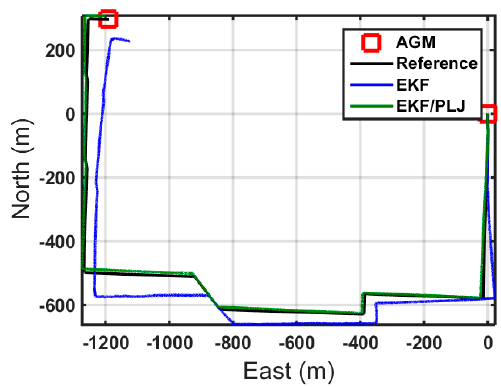
Figure 15. Trajectories—Scenario #2.